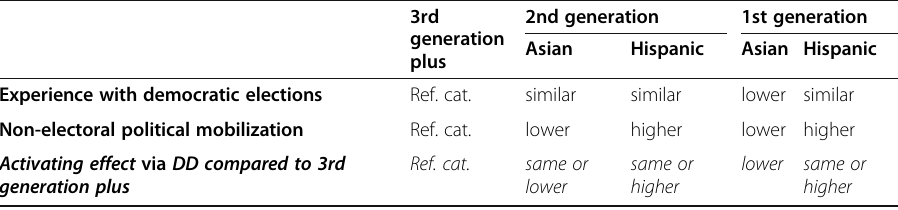
Table 1 Explanatory model for group responsiveness to direct democratic elections